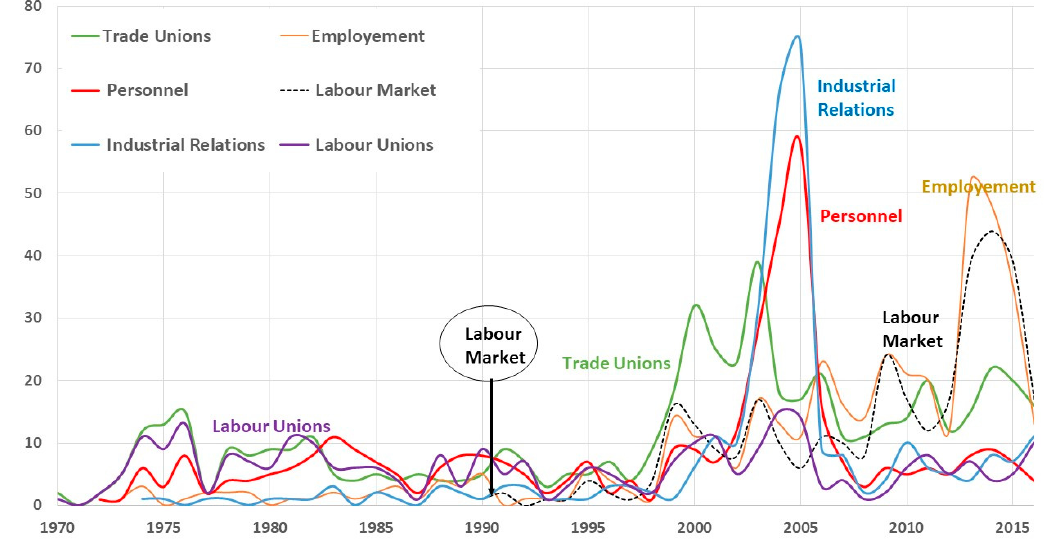
Figure 10. Keywords evolution related to labour relations worldwide research (1970–2016).